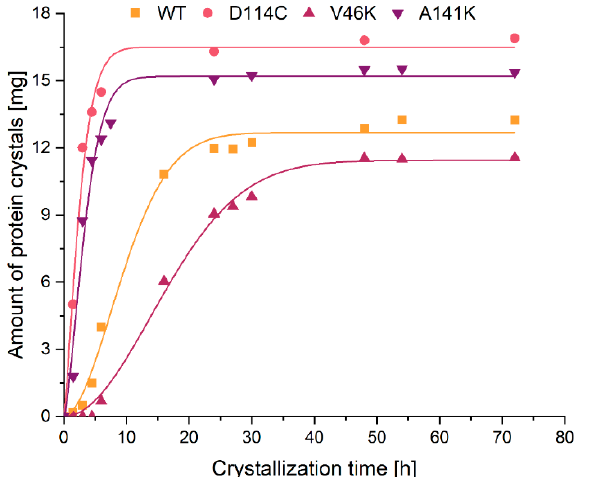
Figure 2. Avrami-based crystallization kinetics of different HheG variants. Crystallization was performed with gentle shaking at 8 °C. A total amount of 24 mg protein was used for